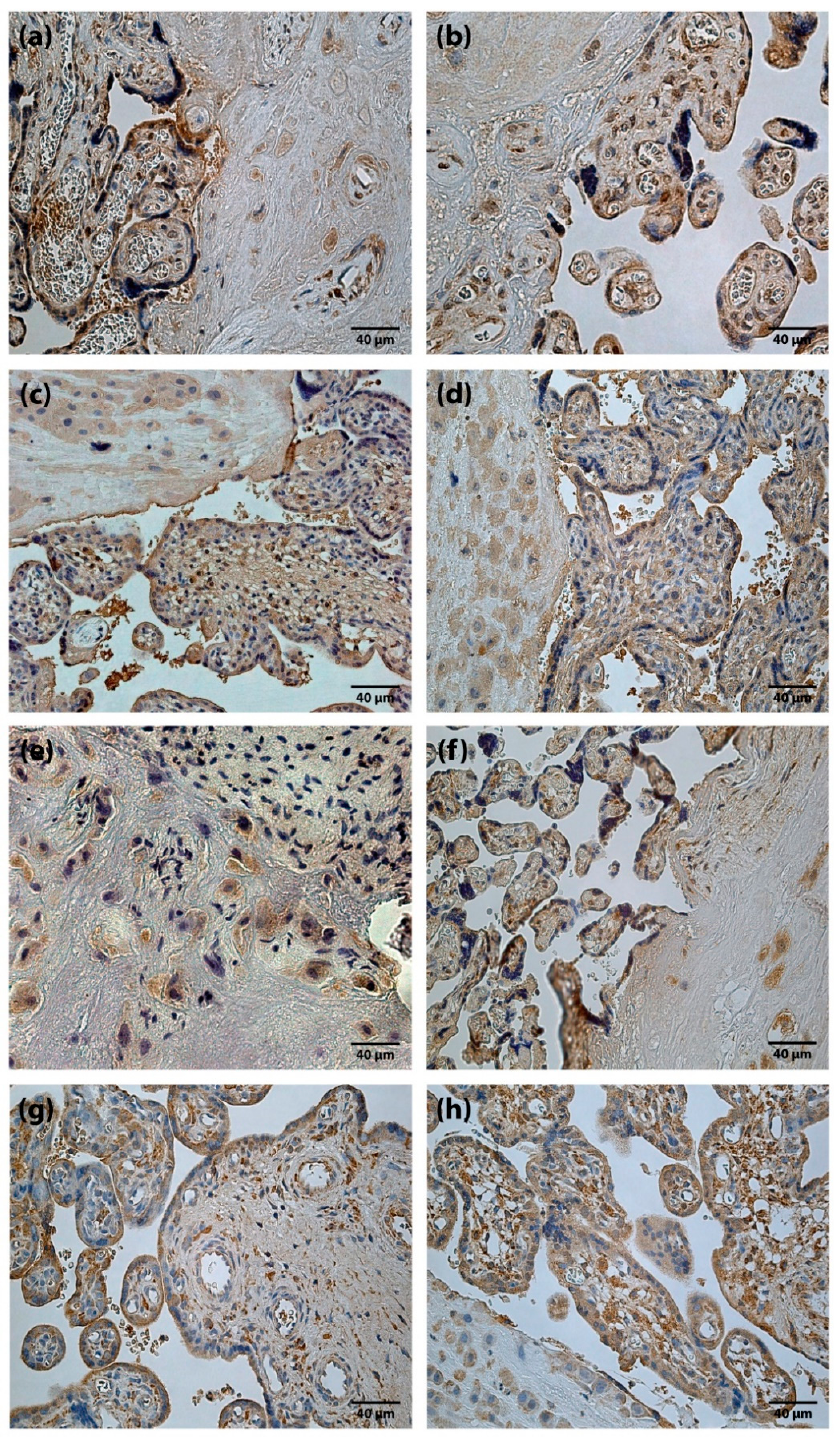
Figure 2. Immunoreactive structures of placenta. ( a ) Moderate amount (++) of TGF β positive cells in a full-term placenta (TGF β IMH, X250). ( b ) Moderate amount (++) of TGF β positive cells in a preterm placenta (TGF β IMH, X250). ( c ) Abundance (++++) of HGF positive cells in a full-term placenta (HGF IMH, X 250). ( d ) Abundance (++++) of HGF positive cells in a preterm placenta (HGF IMH, X 250). ( e ) Moderate amount (++) of FGF-2 positive cells in a full-term placenta (FGF-2 IMH, X 250). ( f ) Moderate amount (++) of FGF-2 positive cells in a preterm placenta (FGF-2 IMH, X 250). ( g ) Moderate to numerous (++/+++) FGFR1 positive cells in a full-term placenta (FGFR1 IMH, X 250). ( h ) Numerous (+++) FGFR1 positive cells in a preterm placenta (FGFR1 IMH, X 250).